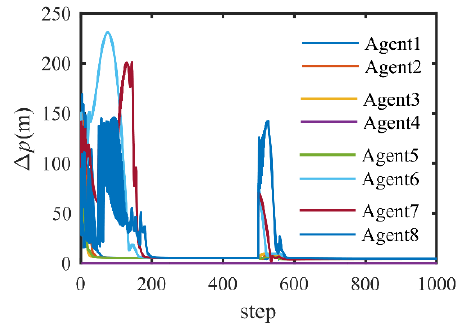
Figure 3. Position errors with linear controller.